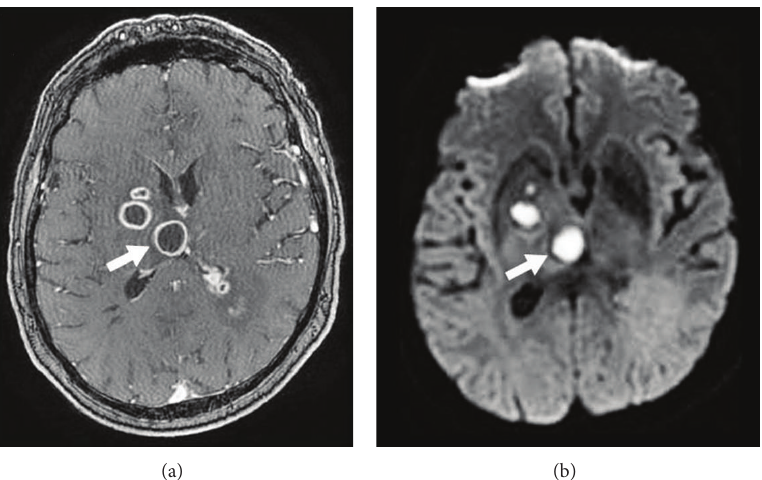
Figure 21: A patient with several brain abscesses involving the right thalamus (arrows) and the basal ganglia, with ring enhancement on gadolinium-enhanced T1-weighted imaging (a) and restricted diffusion seen as hyperintensity on DWI imaging (b).